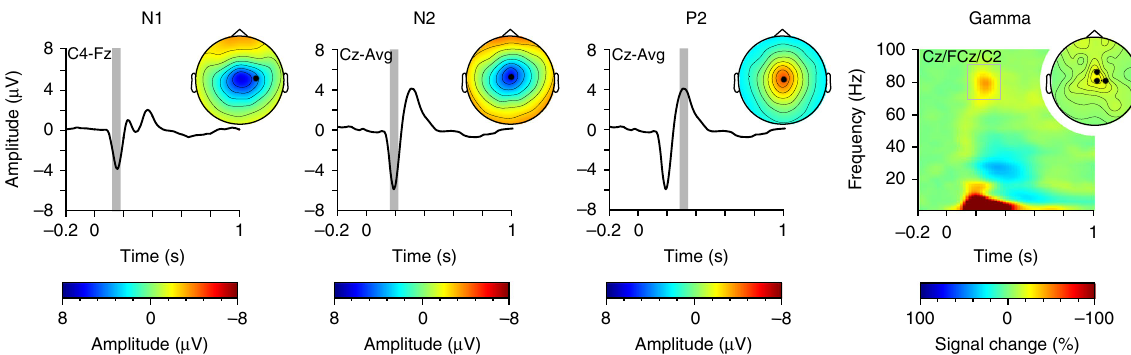
Fig. 3 Brain responses to noxious stimuli. Mean time courses and time-frequency representation (TFR, right panel) of brain responses averaged across conditions and participants. Marked time periods and time-frequency windows indicate periods/windows chosen to quantify N1, N2, P2, and gamma responses. Topographies depict the scalp distribution of neural activity in these periods/windows, electrodes used for the quanti fi cation of the different responses are marked. For visualization only, the TFR is displayed as %-signal change relative to a prestimulus baseline ( − 1000 to 0